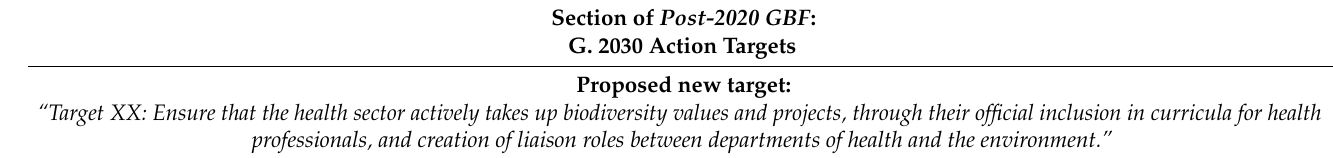
Table 6. Suggested new health target and rationale for “Section G. 2030 Action Targets” within